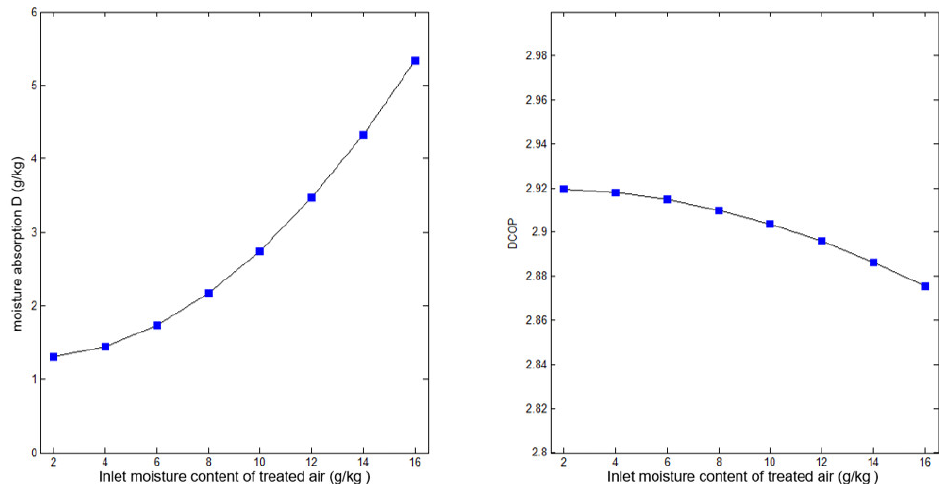
Figure 14. Effect of moisture content of air inlet on moisture absorption D and DCOP.